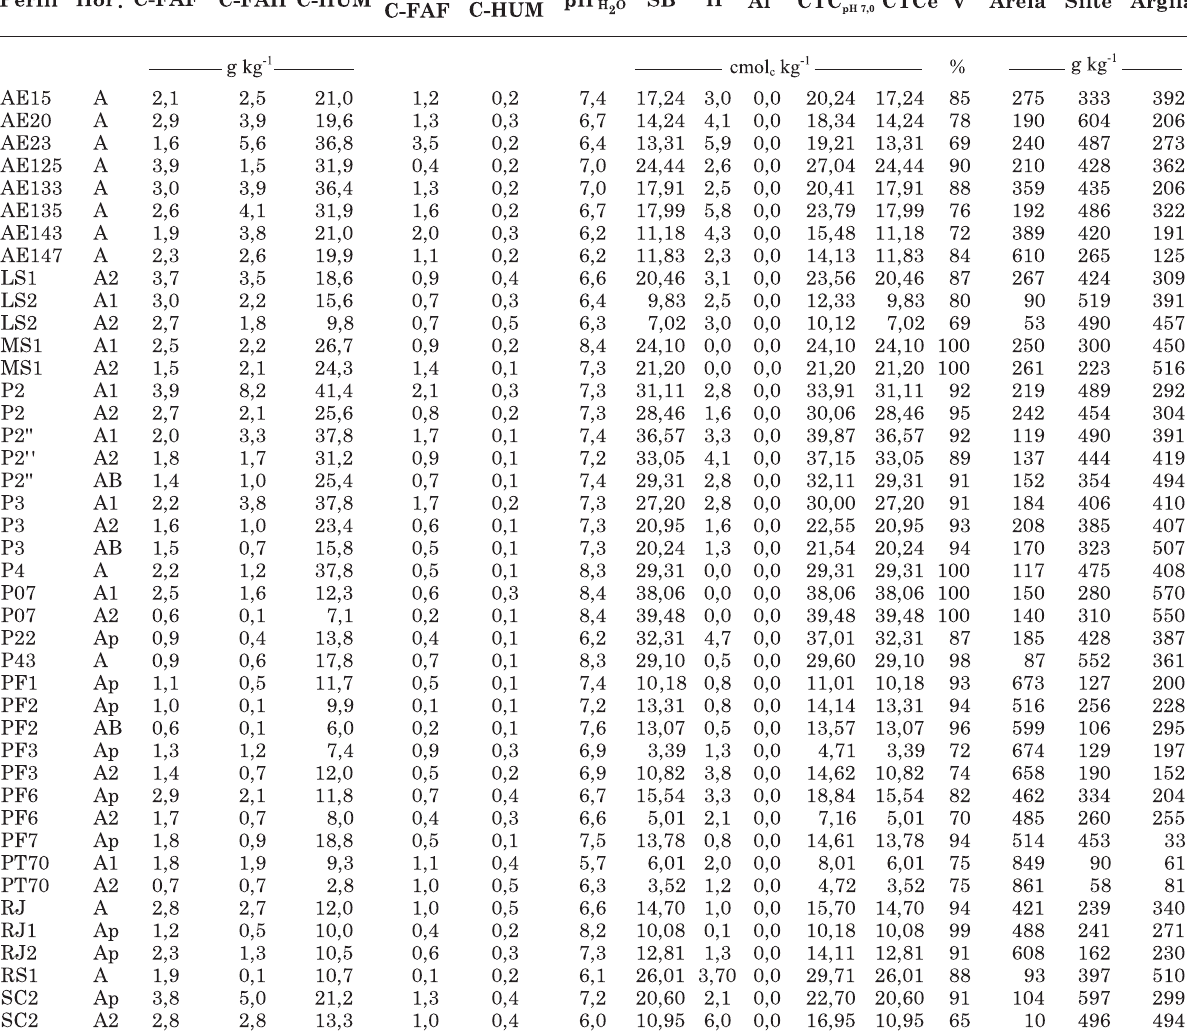
cátions efetiva; V%: saturação por bases. C-EA: carbono orgânico do extrato alcalino (C-FAF +